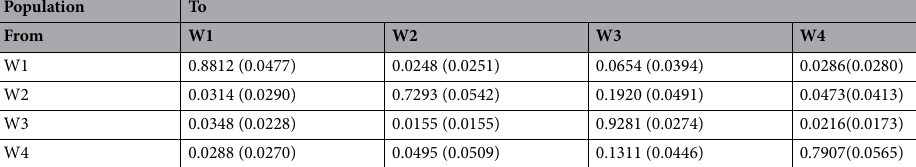
Table 5. Contemporary gene flow ( m , migration rate, results from BAYESASS) estimated between the four wild genetic clusters of the red-fronted macaw in the wild. Standard deviation of the marginal posterior distribution for each estimate is noted in parentheses. Migration rates indicate the fraction of individuals in the population of destination that are migrants derived from the source population (per generation).